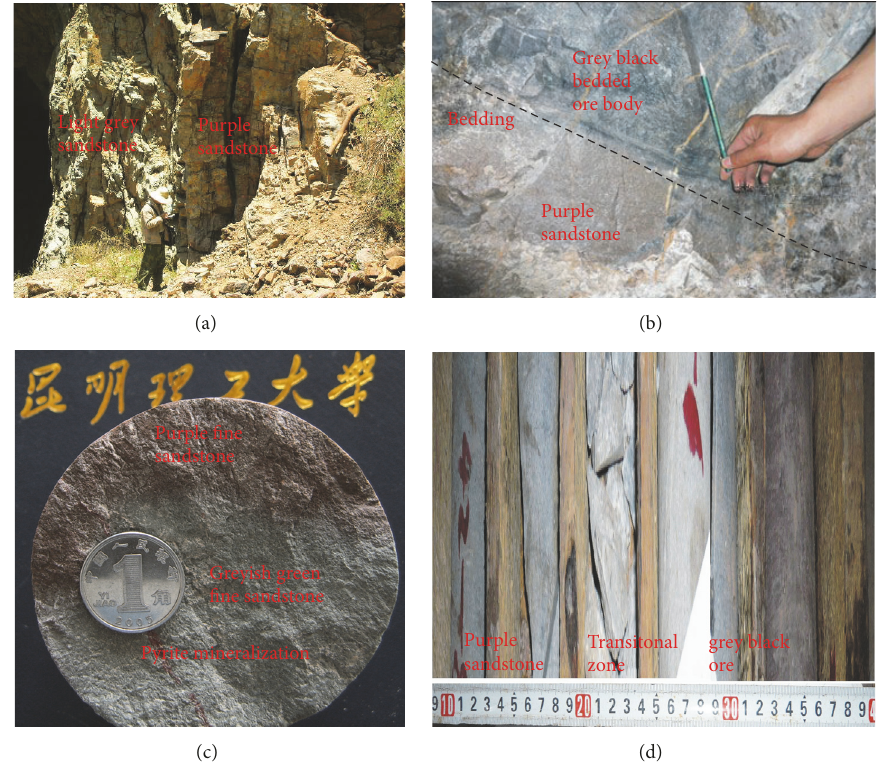
Figure 4: The macroscopic geological characteristics with the change of purple to light grey in Dayao copper deposit. (a) 074DB-29 point: the boundary line between the purple sandstone and the light grey sandstone in bottom of K 2 ml 1 in Shimenkan. Silicified and alteration happened in light grey sandstone side and it made the purple sandstone fade; (b) MK16: the boundary line of purple under the bedding and light grey above the bedding because of the hydrothermal metasomatism along the bedding, the color on the plate, and fracture into light grey to grey; (c) 96 m of ZK1503-1 drill: the transition between the purple fine sandstone and the greyish green fine sandstone in K 2 ml 2 , pyrite mineralization in greyish green fine sandstone; (d) ZK15103: the transition of purple and light grey and the mineralization characteristics (left: purple sandstone; middle: transition of purple and light grey; and right: grey black ore).